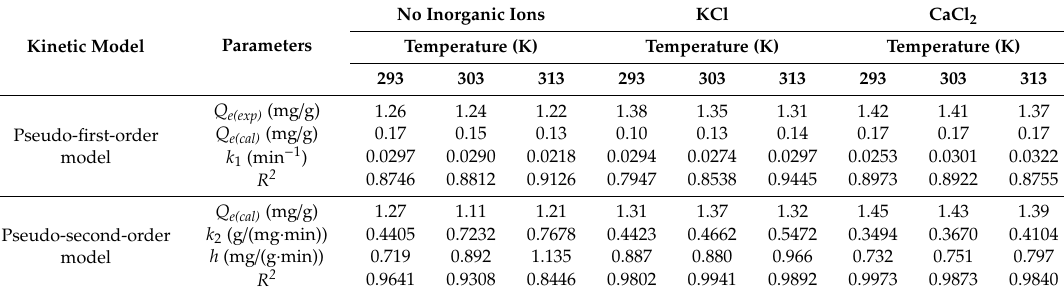
Table 6. Kinetic parameters for the adsorption of quinoline onto coke